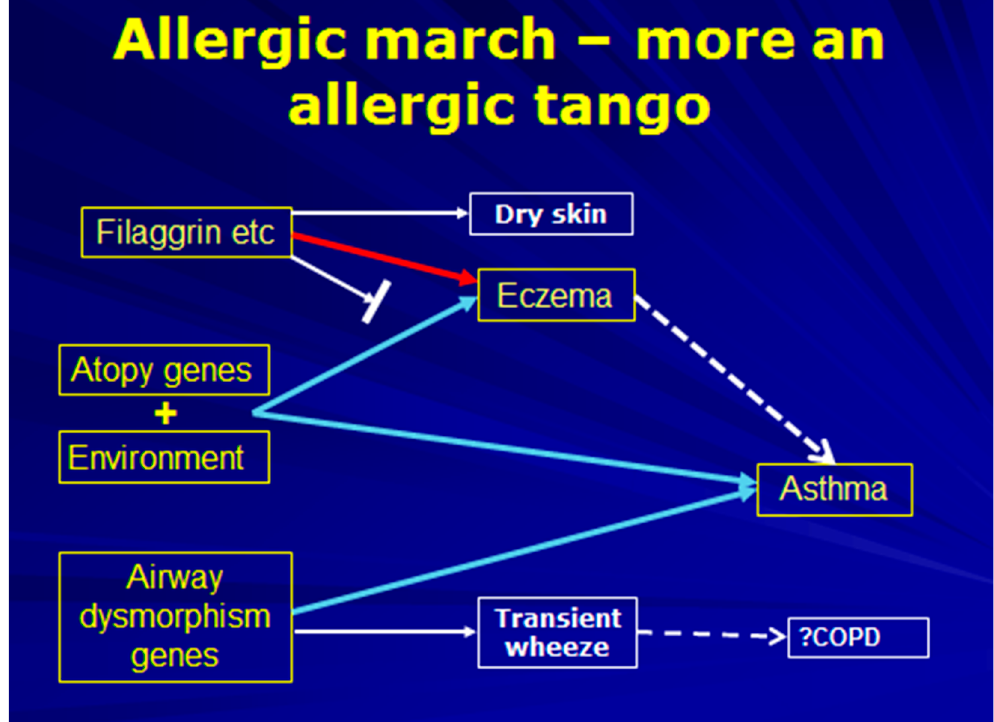
Figure 3. An illustration of the complex relationships between various allergic phenotypes. Constituting not an allergic march but more a complex dance such as the tango.